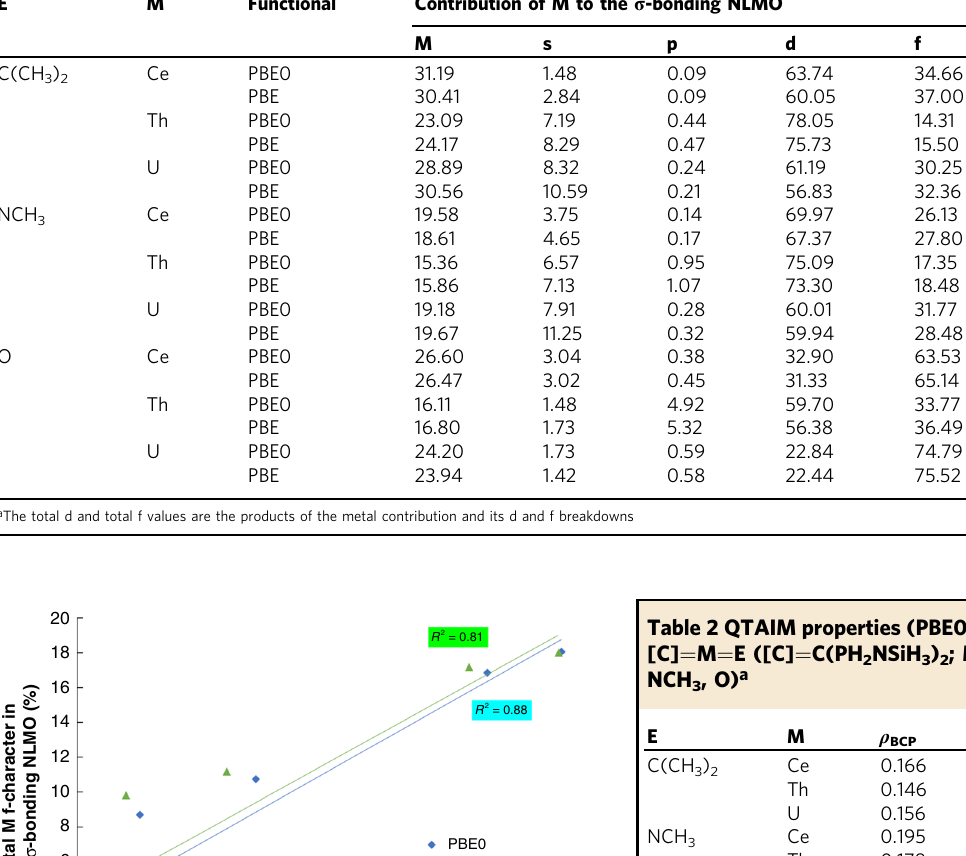
Table 1 Composition (%) of the M – E σ bonding NLMOs of [C] = M = E ([C] = C(PH 2 NSiH 3 ) 2 ; M = Ce, Th, U; E = C(CH 3 ) 2 , NCH 3 , O) at their optimised geometries a E M Functional Contribution of M to the σ -bonding NLMO